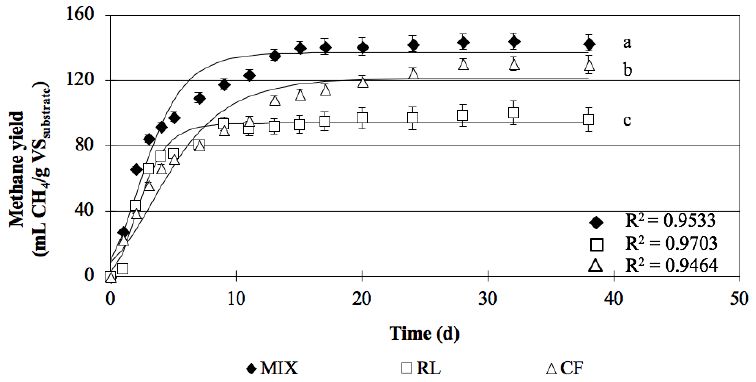
Figure 2. Methane yield from Napier grass with difference sludges (symbols—observed data, dashed lines—predicted data with the Gompertz model).